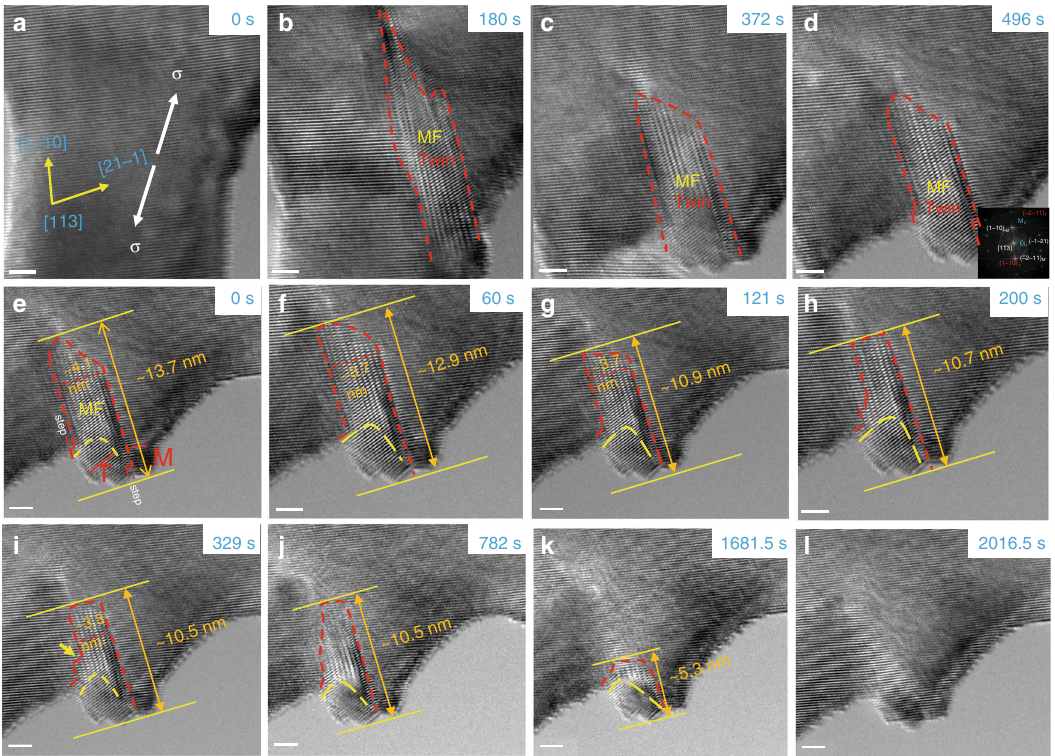
Fig. 1 The spontaneous detwinning in the deformation twin containing ~70% Moiré fringes region. a – d The formation of the deformation twin under tension. e – l Spontaneous detwinning process upon unloading. Scale bar, 2